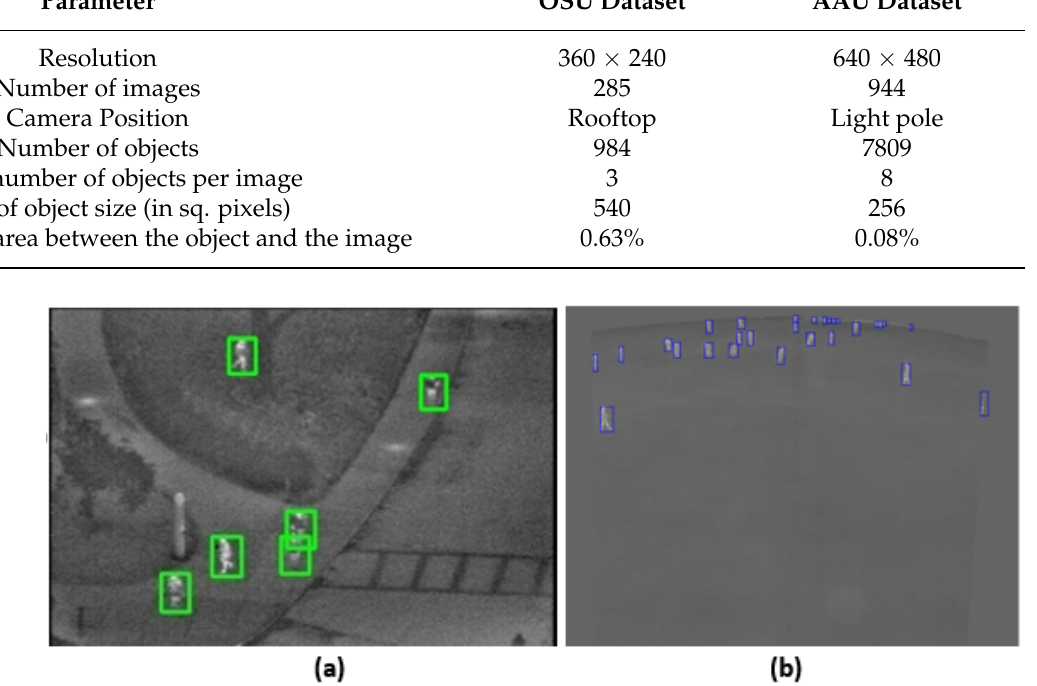
Figure 5. Sample annotated images from ( a ) OSU dataset ( b ) AAU PD T